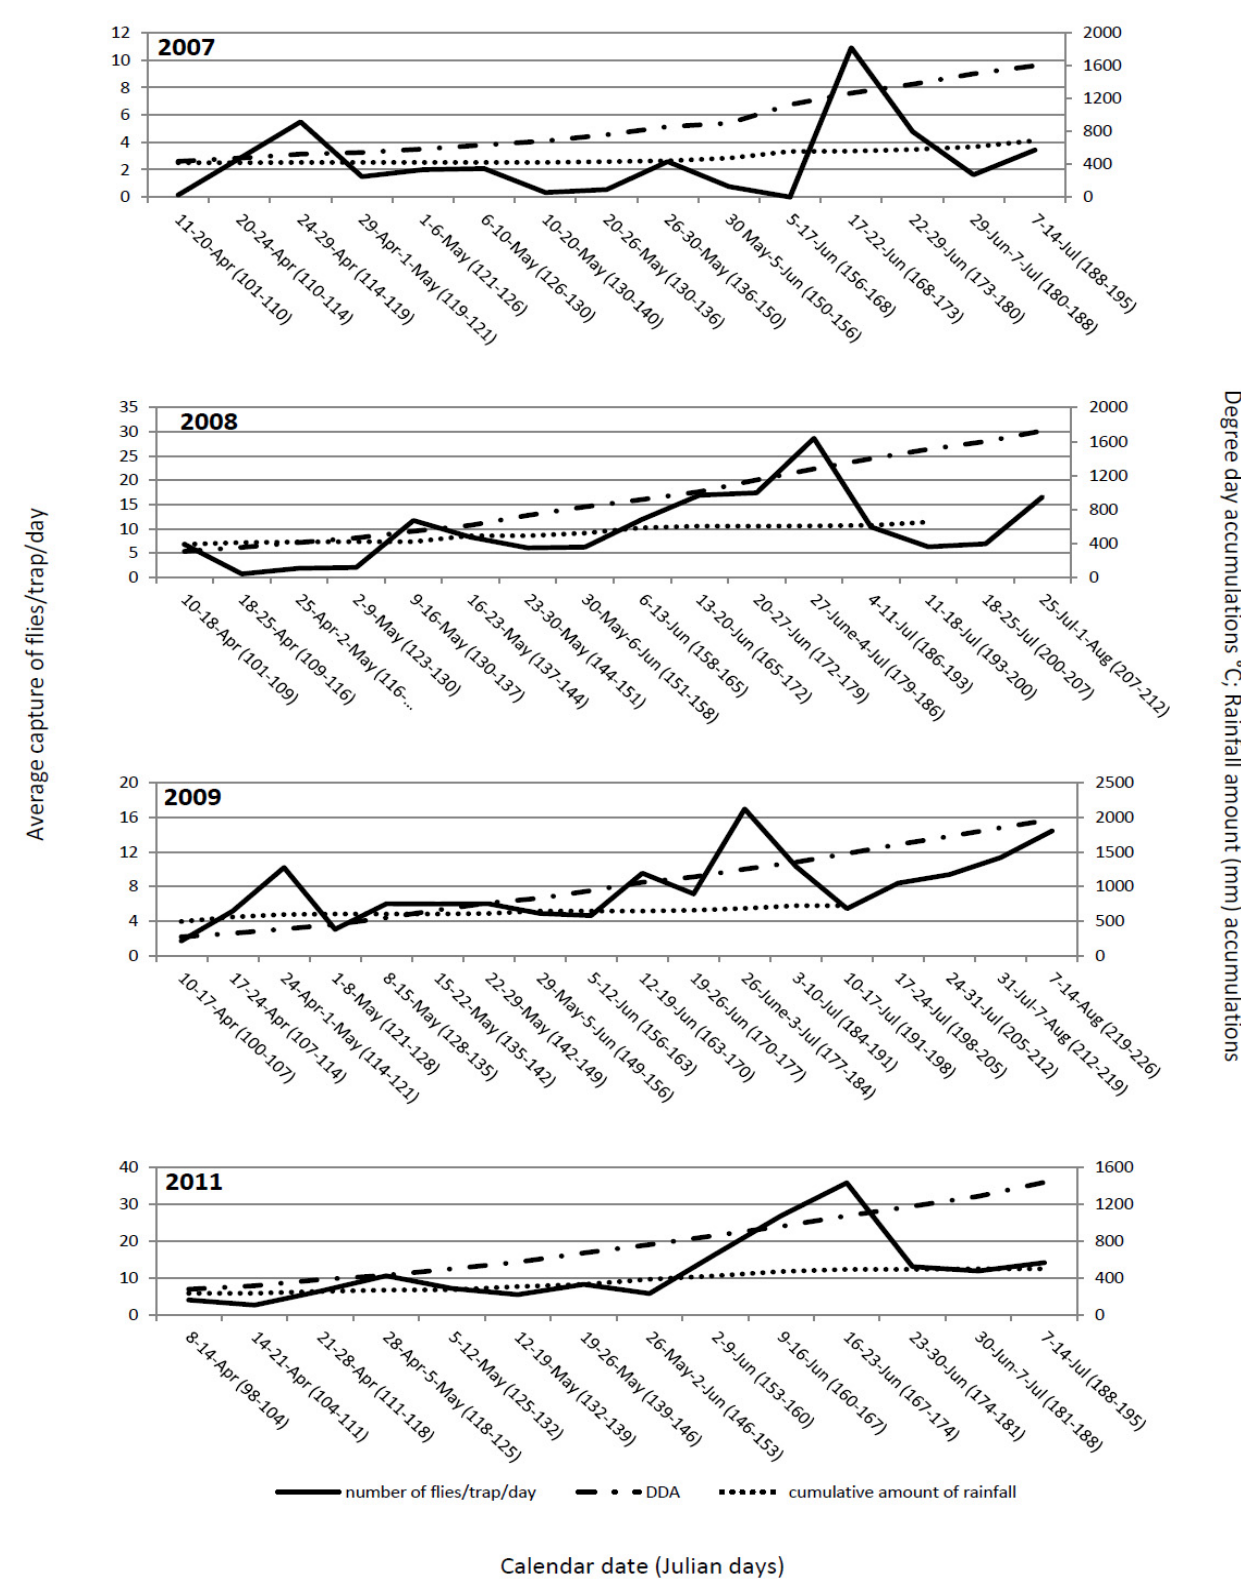
Figure 1. Delia radicum (L.) adult captures per trap per day on yellow sticky traps in early cabbage fields in Ogulin, Croatia compared with DDA (base 4.3 °C base threshold), and the cumulative amount of precipitation over four field seasons (2007 to 2009,